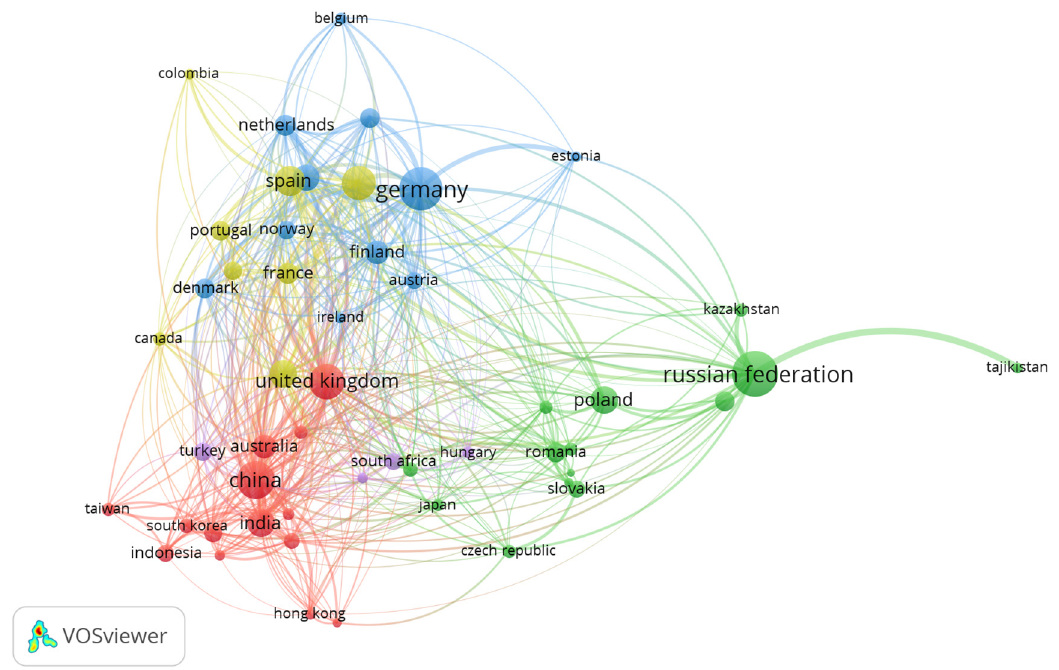
Figure 3. Graphical representation of the links between scientific papers, by country. Source: processing done by the authors with VOSViewer, based on the data interrogated in the Scopus database.